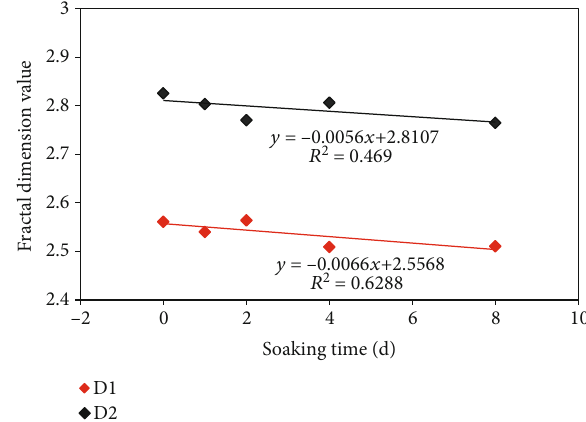
Figure 8: Relationship between fractal dimensions and SSA.